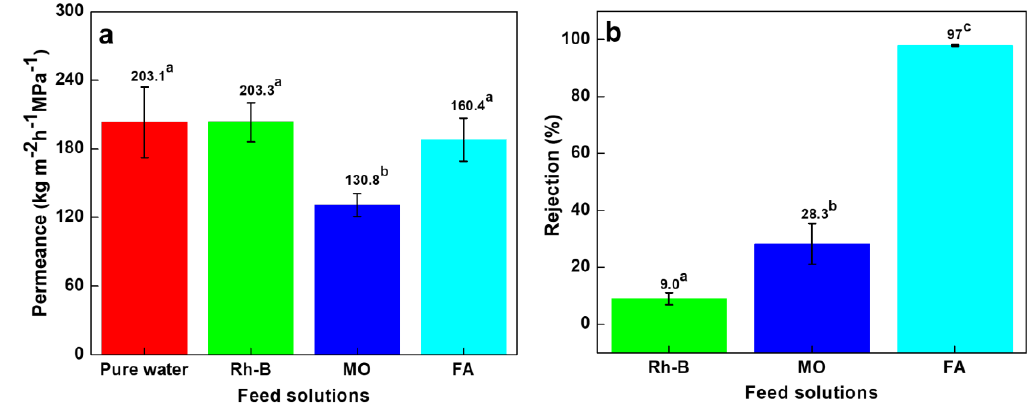
Figure 6. Nonwoven / PVDF-PAA membrane filtration performance: ( a ) permeance and ( b ) rejection data for Rhodamine B, methyl orange (both 10 ppm) and 500 ppm folic acid solutions. Data with different letters are significantly different at 5% significance level. The permeance of pure water is included for comparison.